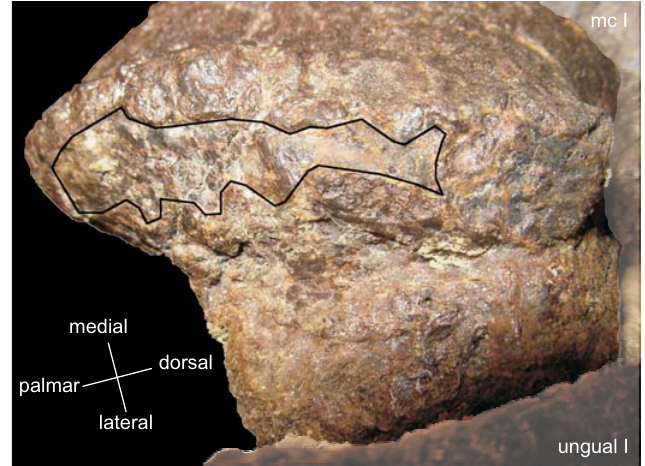
Fig. 7. Smoothened area (a possible case of eburnation) on the distal ar- ticular surface of the left manual phalanx I-1 of the camarasaurid sauro- pod SMA 0002 from Upper Jurassic Morrison Formation, Howe-Stephens Quarry, Wyoming, USA. The distal dorsopalmar height is 55 mm.